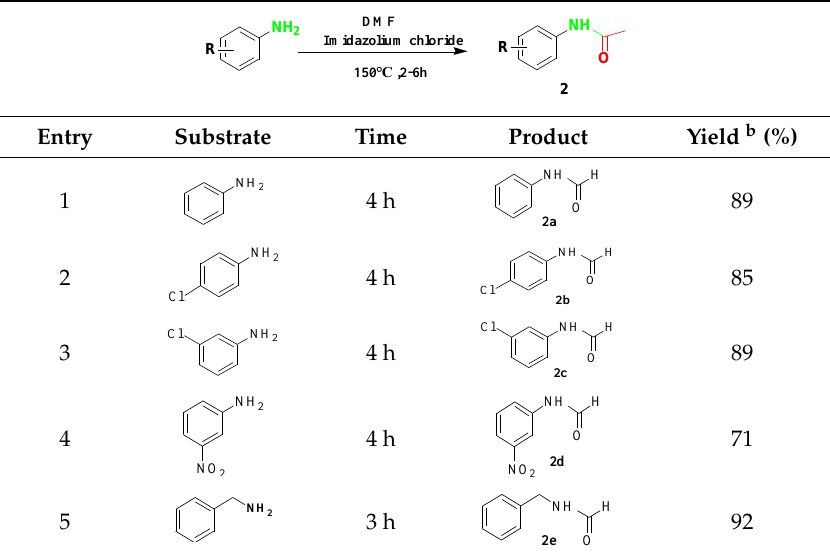
Table 3. N -benzamides of amines 2a – 2e a .